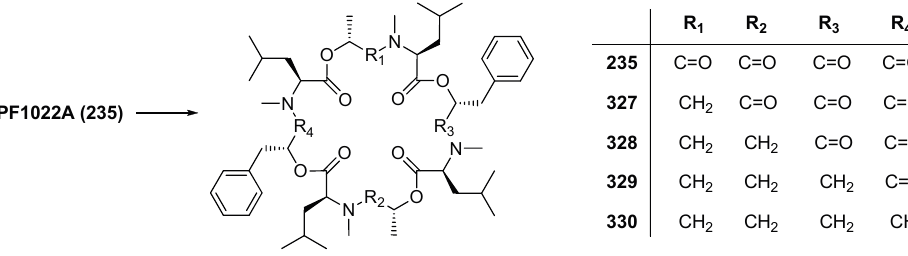
Figure 30. Backbone modification of PF1022A by reduction using BH